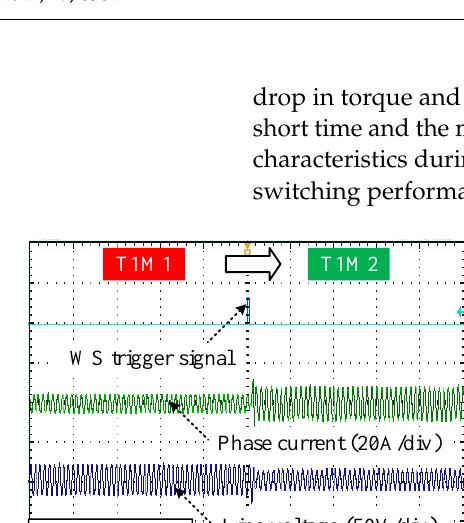
( b ) Figure 11. Characteristics of no-load back-EMF during the WS process. ( a ) From T1M1 to T1M2 at 500 rpm. ( b ) From T1M2 to T1M3 at 1000 rpm. According to the description of the proposed WS strategy and the test results in Figure 10, the WS operations at the working point A and B were selected to exhibit the on- load WS performance for the DS-PMM prototype at 500 rpm and 1000 rpm, respectively. Figure 12 shows the on-load WS transient characteristics from T1M1 to T1M2 at 500 rpm